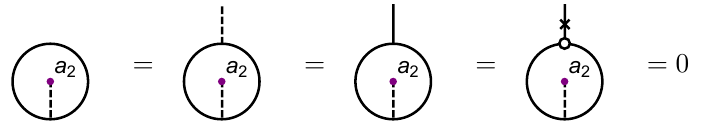
= 0, which follow from the Z 2 -invariance, 0 ; 1